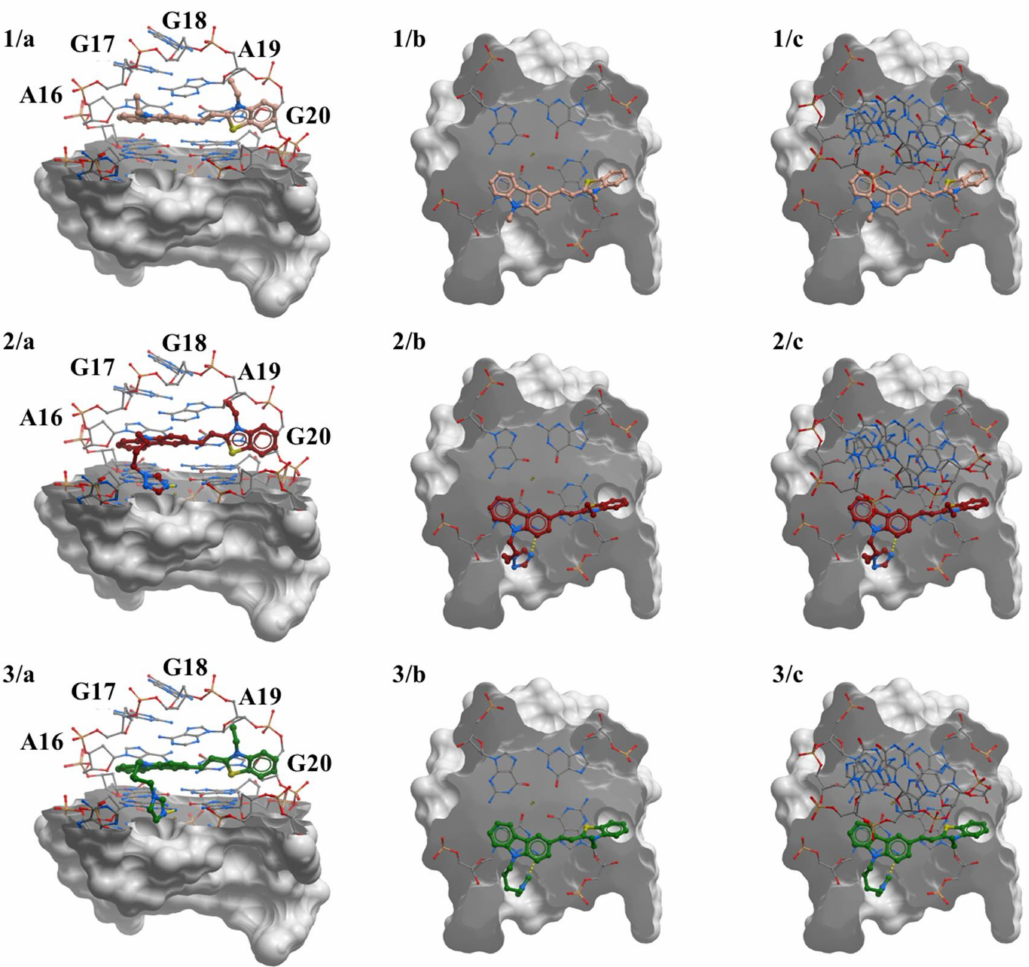
Figure 8. Docked ligands 1 , 2 and 3 on external G-tetrads of parallel-stranded G-quadruplex (PDB id 2O3M). Cartoons representing ( a ) the side view of the complex. In ( a ), the 3 (cid:48) terminal quartet is illustrated as sticks and the 5 (cid:48) end in a surface representation. The next two illustrations highlight ( b ) the top view of the 3 (cid:48) quartet (without the loop) and ( c ) the 3 (cid:48) quartet with the loop. Hydrogen bonds are highlighted as yellow dotted